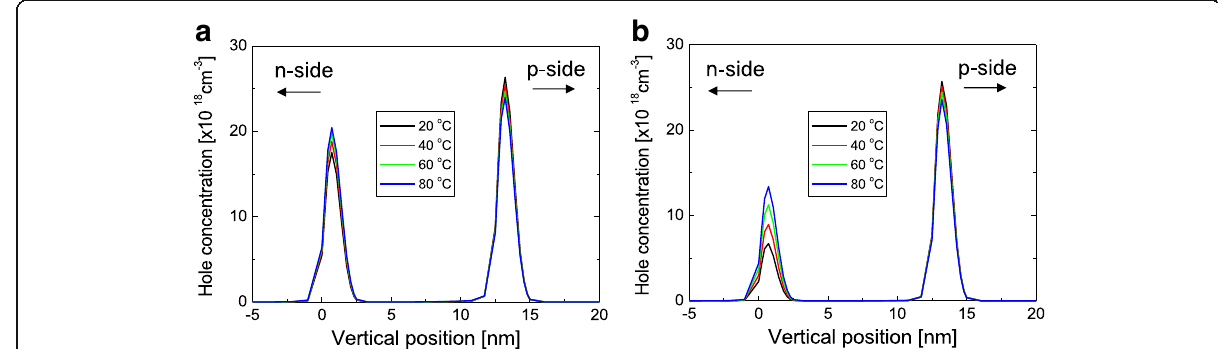
Fig. 5 Hole concentration distribution at 30 mA for temperatures of 20, 40, 60, and 80 °C when the n-type doping concentration of the barrier are a 1 × 10 17 cm − 3 and b 2 × 10 18 cm − 3 . Here, the barrier thickness is fixed at 10